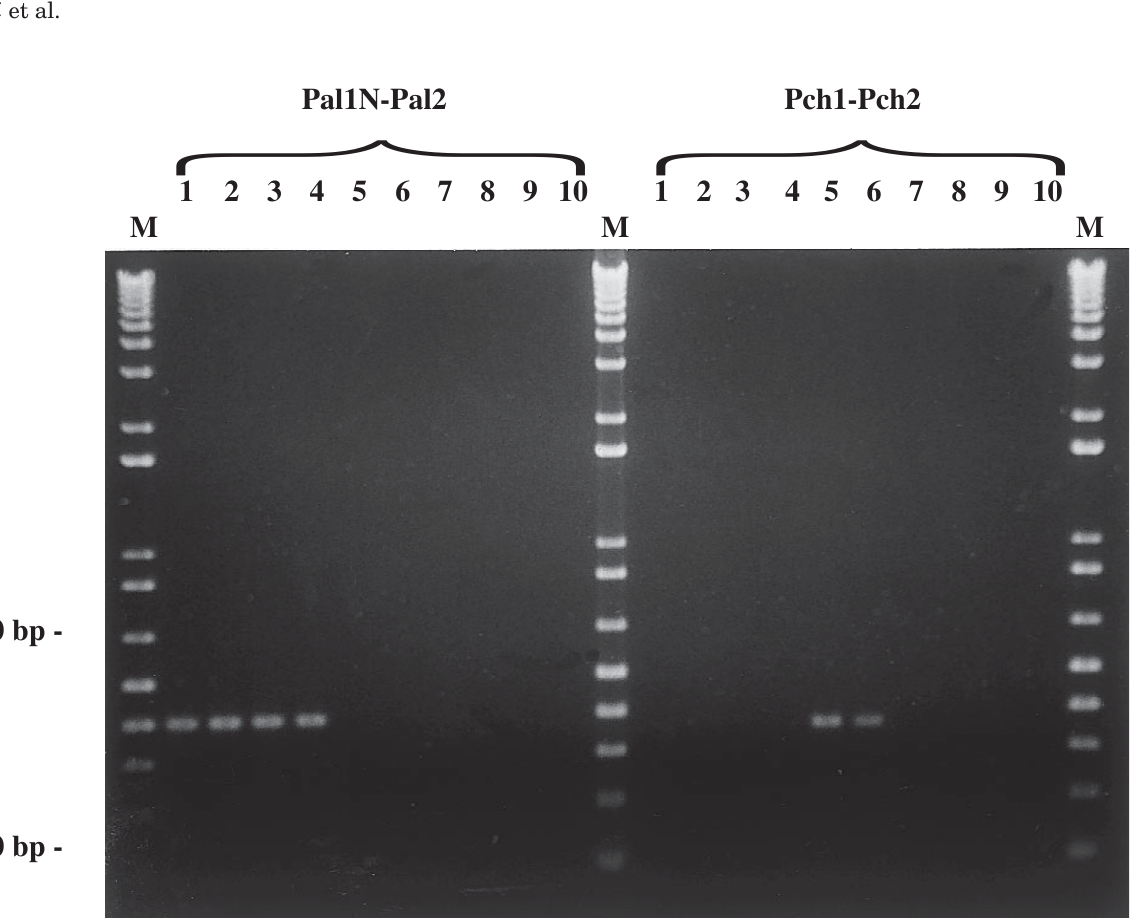
Fig. 3. Agarose gel of the PCR products using primer pairs Pal1N-Pal2 and Pch1-Pch2. Lanes 1-2, P. aleophilum 157 and CBS 246.91; lane 3, P. angustius CBS 249.95; lane 4, P. inflatipes CBS 222.95; lanes 5-6, P. chlamydosporum 56 and CBS 161.90; lane 7, P. angustius CBS 777.83; lane 8, P. inflatipes CBS 391.71; lane 9, P. rubrigenum CBS 498.94; lane 10, negative control of sterile distilled water; lane M, 1Kb Plus DNA Ladder (Gibco-BRL, Life